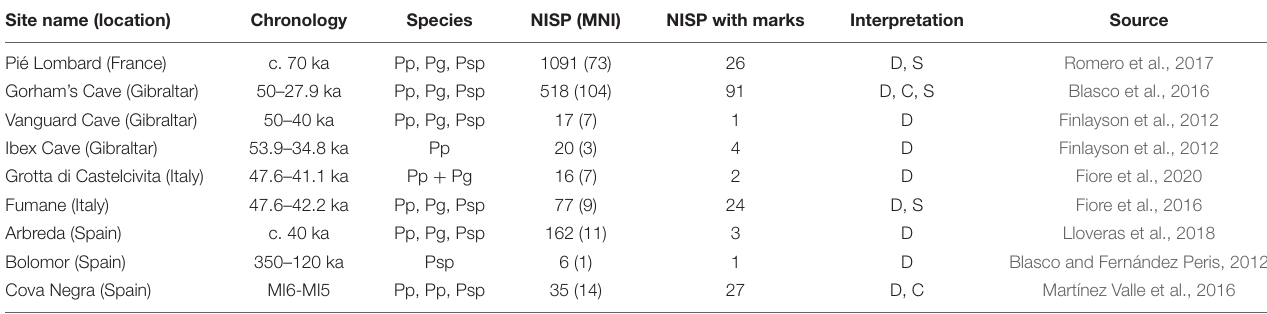
TABLE 1 | Number of identified specimens (NISP), minimum number of individuals (MNI), and NISP with evidence of anthropogenic processing marks on chough fossil bones at Mousterian